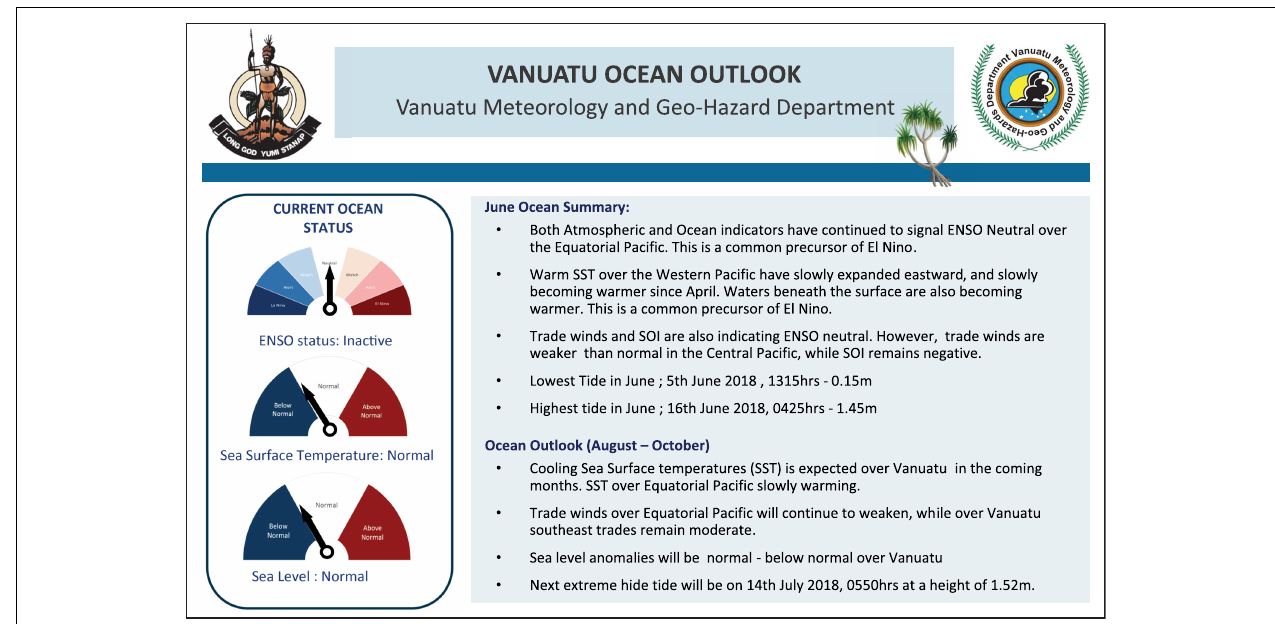
FIGURE 6 | Excerpt from the English language version of the Vanuatu Ocean Outlook Bulletin. Developed by the Vanuatu Meteorology and Geo-Hazards Department, this document provides the community with information helpful for planning efforts in various sectors, such as fisheries. Image courtesy of Vanuatu Meteorology and Geo-Hazards